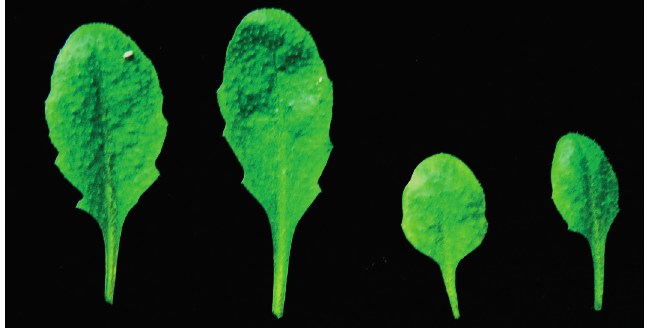
Figure 7. The two leaf types that were examined; fully developed mature leaves ( left ) and developing young leaves ( right ). Young leaves were considered those in the center of the leaf rosette with 1.25 ± 0.21 cm length, while mature leaves those with a length of 2.25 ± 0.25